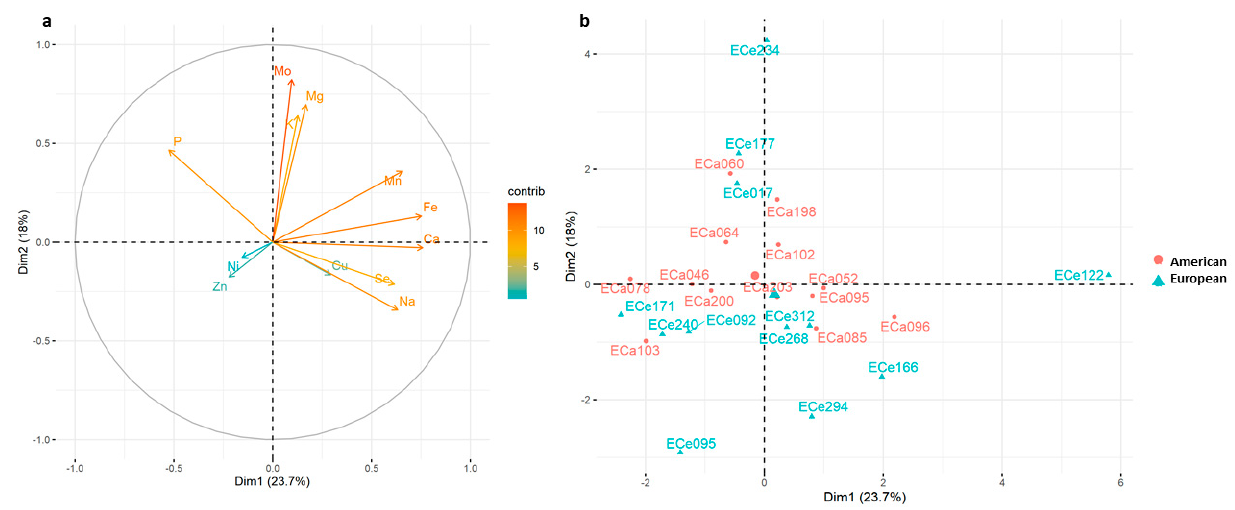
Figure 6. ( a ) Principal component analysis for the 25 American and European accessions based on macro-elements (Ca, K, Mg, Na, P) contents and micro-elements (Cu, Fe, Mn, Mo, Ni, Se, Zn) contents; ( b ) loading plot from the principal component analysis. Positive correlated variables point to the same side of the plot, negative to opposite sides. Color gradient (from red to blue) indicates contribution of each variable to each dimension. A, American accessions; E, European accessions. Table 7. Correlation coefficients between the principal components, PC1 and PC2, and macro- elements (Na, Mg, P, K, Ca) contents and micro-elements (Fe, Zn, Mn, Cu, Se, Mo, Ni) contents. Only significant correlations are shown ( p <